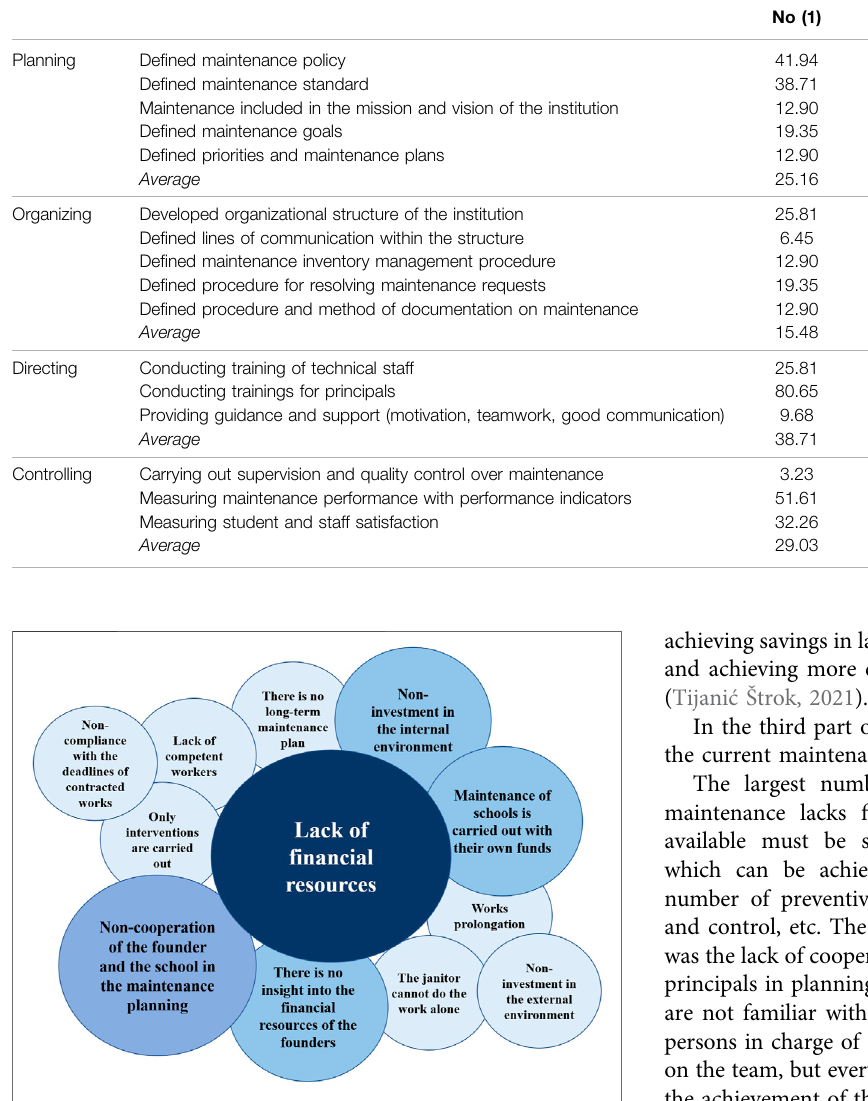
Frontiers in Built Environment |